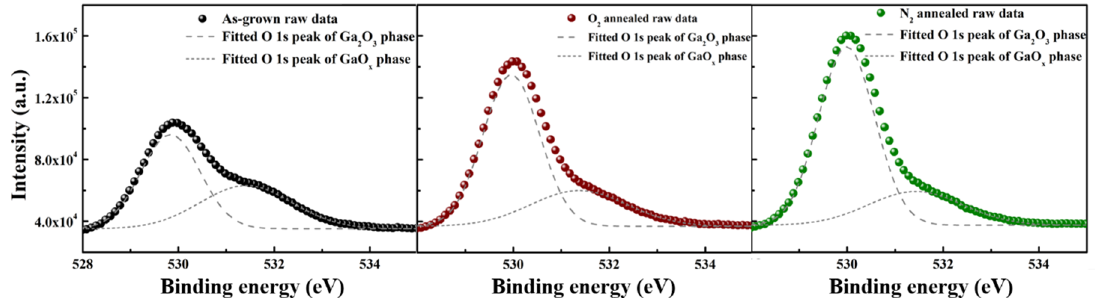
Figure 4. O 1s XPS spectra of the Ga 2 O 3 films annealed under different atmospheres.